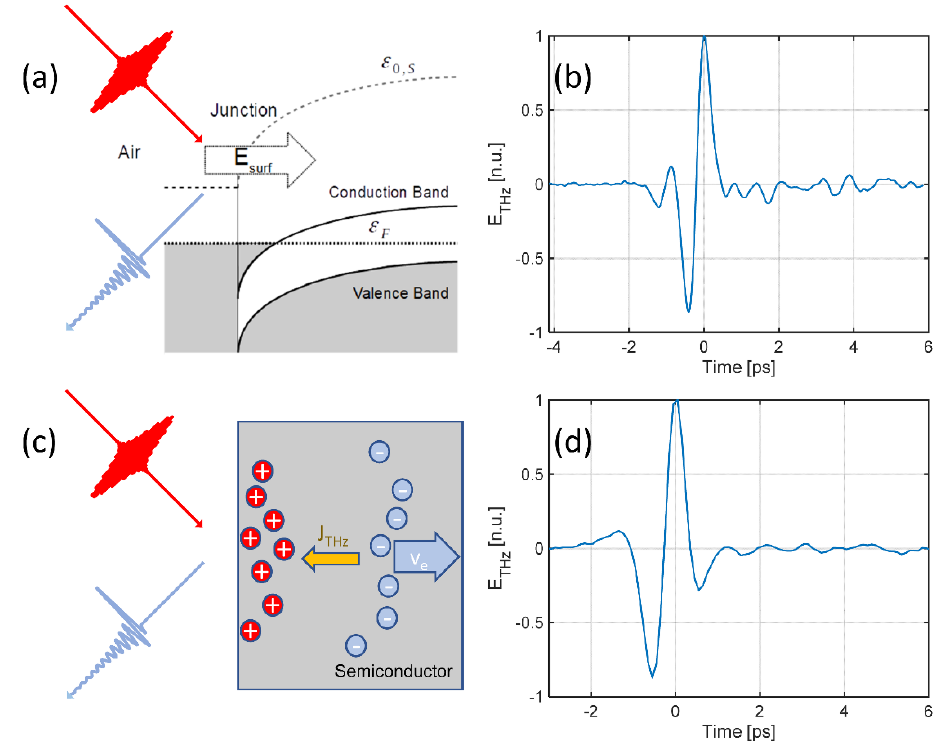
Figure 5. Surface emission driving mechanisms. ( a ) Surface optical rectification—a surface field at the air–semiconductor barrier combines with the optical field in a four-wave mixing process (cubic), generating a terahertz mixing product (see Equation (7)). ( b ) Measurement of the terahertz emission using surface optical rectification with an optical pulsed excitation fluence of 7 mJ/cm 2 (1 kHz repetition rate) and a pulse with a wavelength of 800 nm and a duration of 90 fs. ( c ) Simplified sketch of the photo-Dember process in InAs. The absorption of an ultrashort pulse generates a high density of photogenerated hole–electron pairs within the optical penetration depth (140 nm). The fast diffusion of the electrons induces a transient current J THz , which is the source of the terahertz emission. ( d ) Measurement of the terahertz emission by photo-Dember mechanism with an optical pulsed excitation fluence of 0.28 µJ/cm 2 (80 MHz repetition rate) and pulse with a wavelength of 800 nm and a duration of 140 fs.